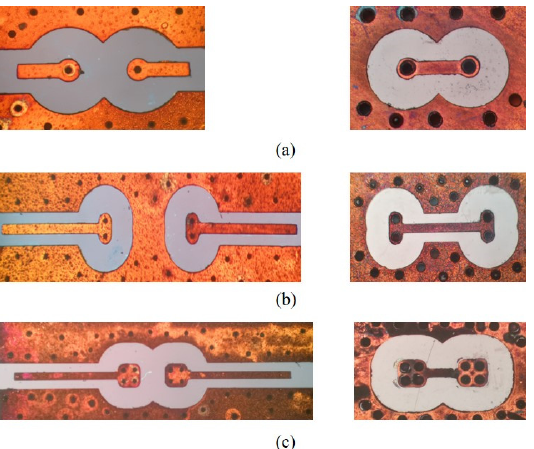
Figure 9. Test structure physical photo: ( a ) single TSV; ( b ) dual redundant TSV; ( c ) quad redun- dant TSV.